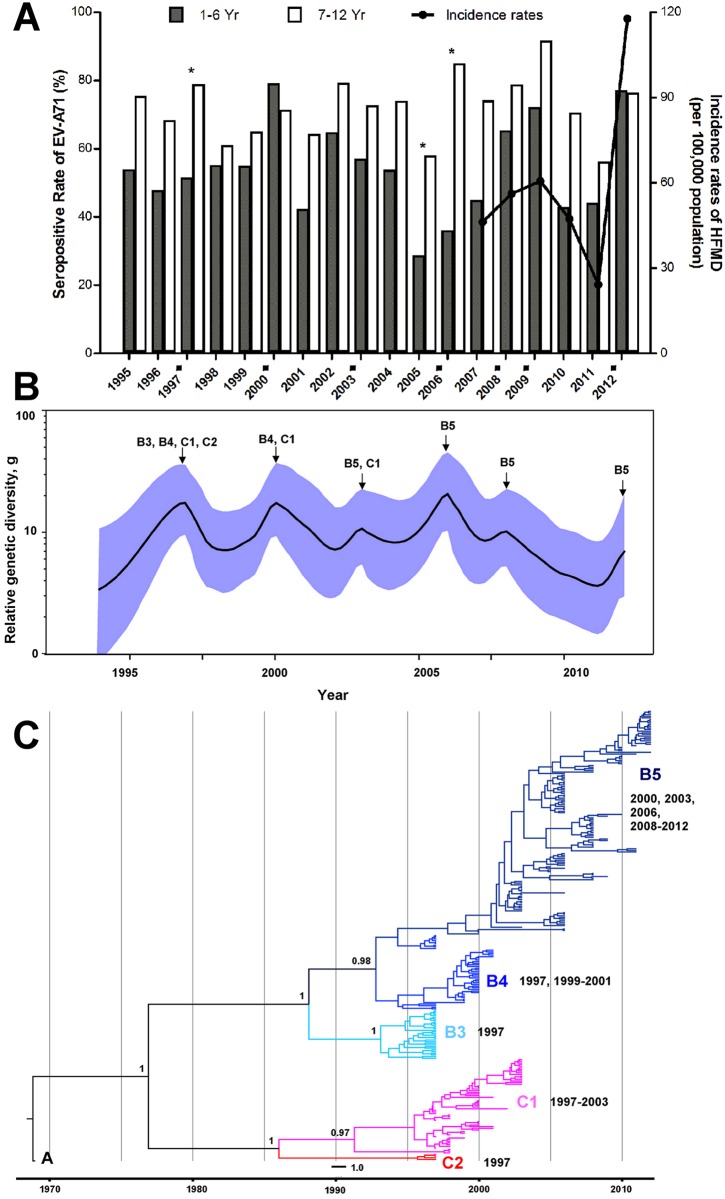
Age-dependent seroprevalence rates of EV-A71 infection in Kuala Lumpur, Malaysia from 1995–2012 and EV-A71 genetic diversity.(A) Seroprevalence rates of EV-A71 infection in 1–6 years (pre-school) and 7–12 years (primary school) age groups are shown. The asterisks indicate significant differences (P<0.05) in seroprevalence between the two age groups after Bonferroni correction for multiple comparisons across individual years. The black squares indicate reported EV-A71 epidemic years. The black line indicates the overall incidence rates of HFMD as reported by the Ministry of Health, Malaysia from 2007 (the statutory notification of HFMD was enforceable only from October 2006). (B) Bayesian Skyride plot estimating the genetic diversity of EV-A71 over time. (C) Maximum clade credibility tree based on VP1 sequences showing the EV-A71 subgenotypes present in Malaysia since the first epidemic in 1997. Posterior probability values are shown at the key nodes. EV-A71 BrCr from genotype A was used as the outgroup.